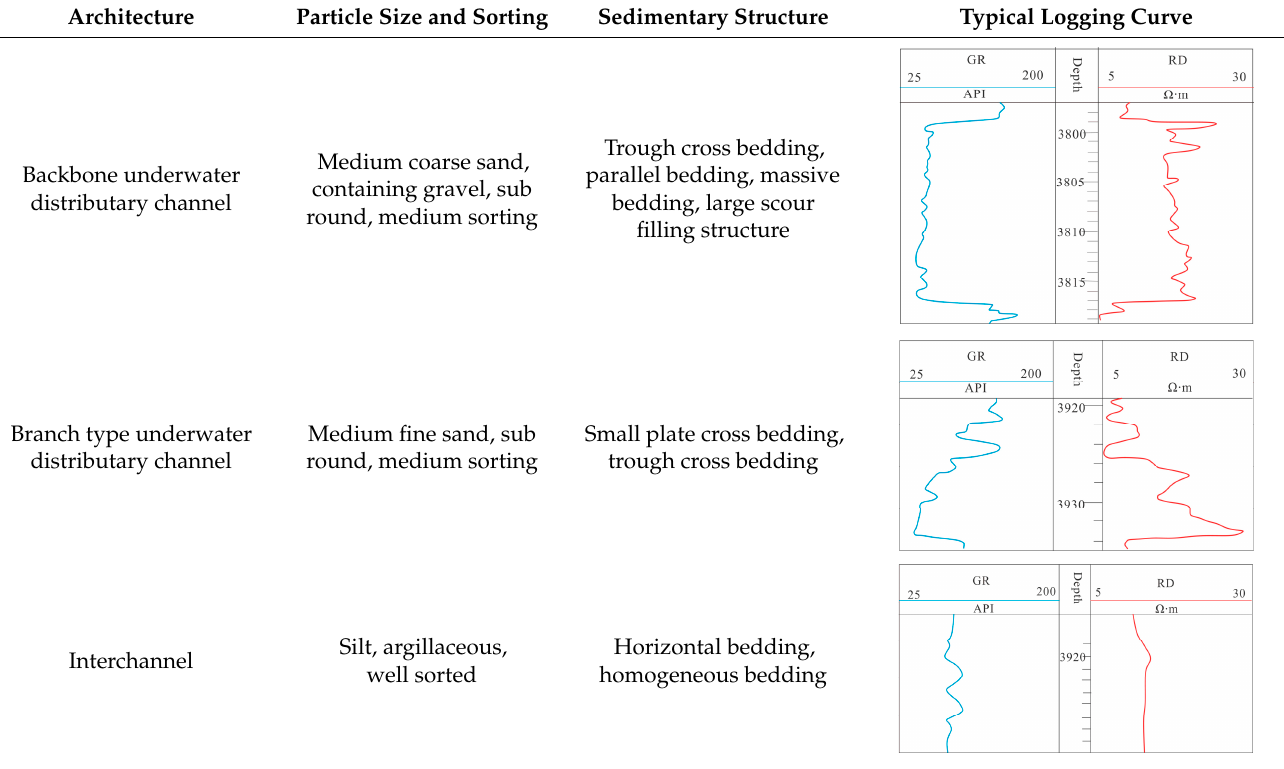
Table 1. Logging architecture model of TIII in the Sangtamu oilfield.